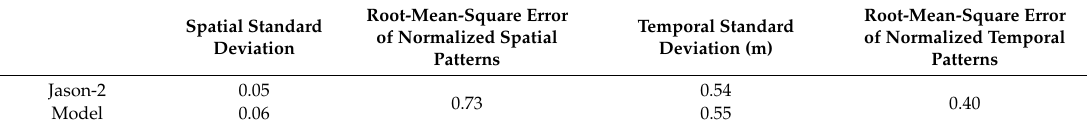
Table 1. Statistics comparing the first EOF mode of Jason-2 and model sea level anomaly from 1 June 2010 to 31 October 2010 with their spatial and temporal standard deviations and root-mean-square errors of their normalized values. Normalized values are defined as the ratio of the first mode patterns to its own standard deviation.